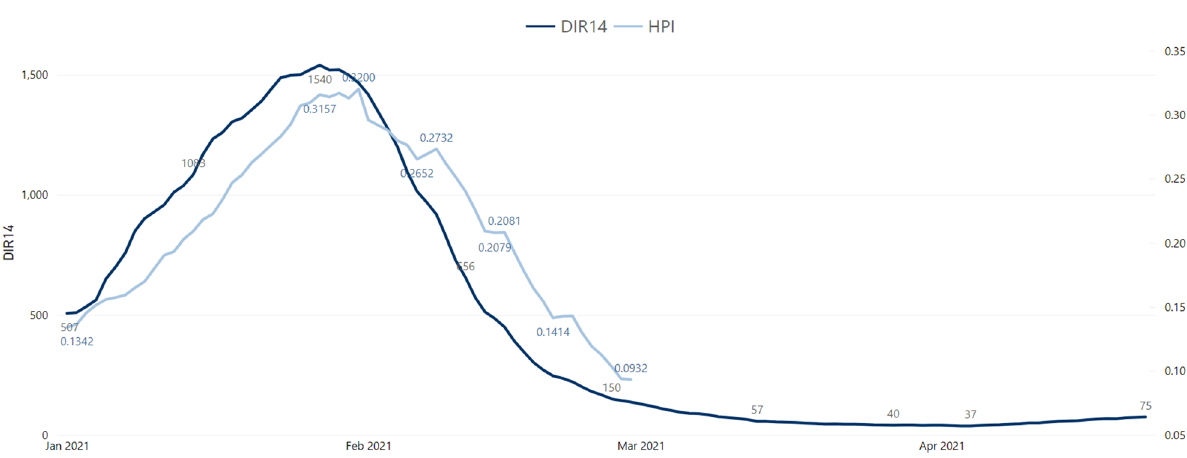
Figure 8. Average DIR14 and HPI, January-April 2021, Porto